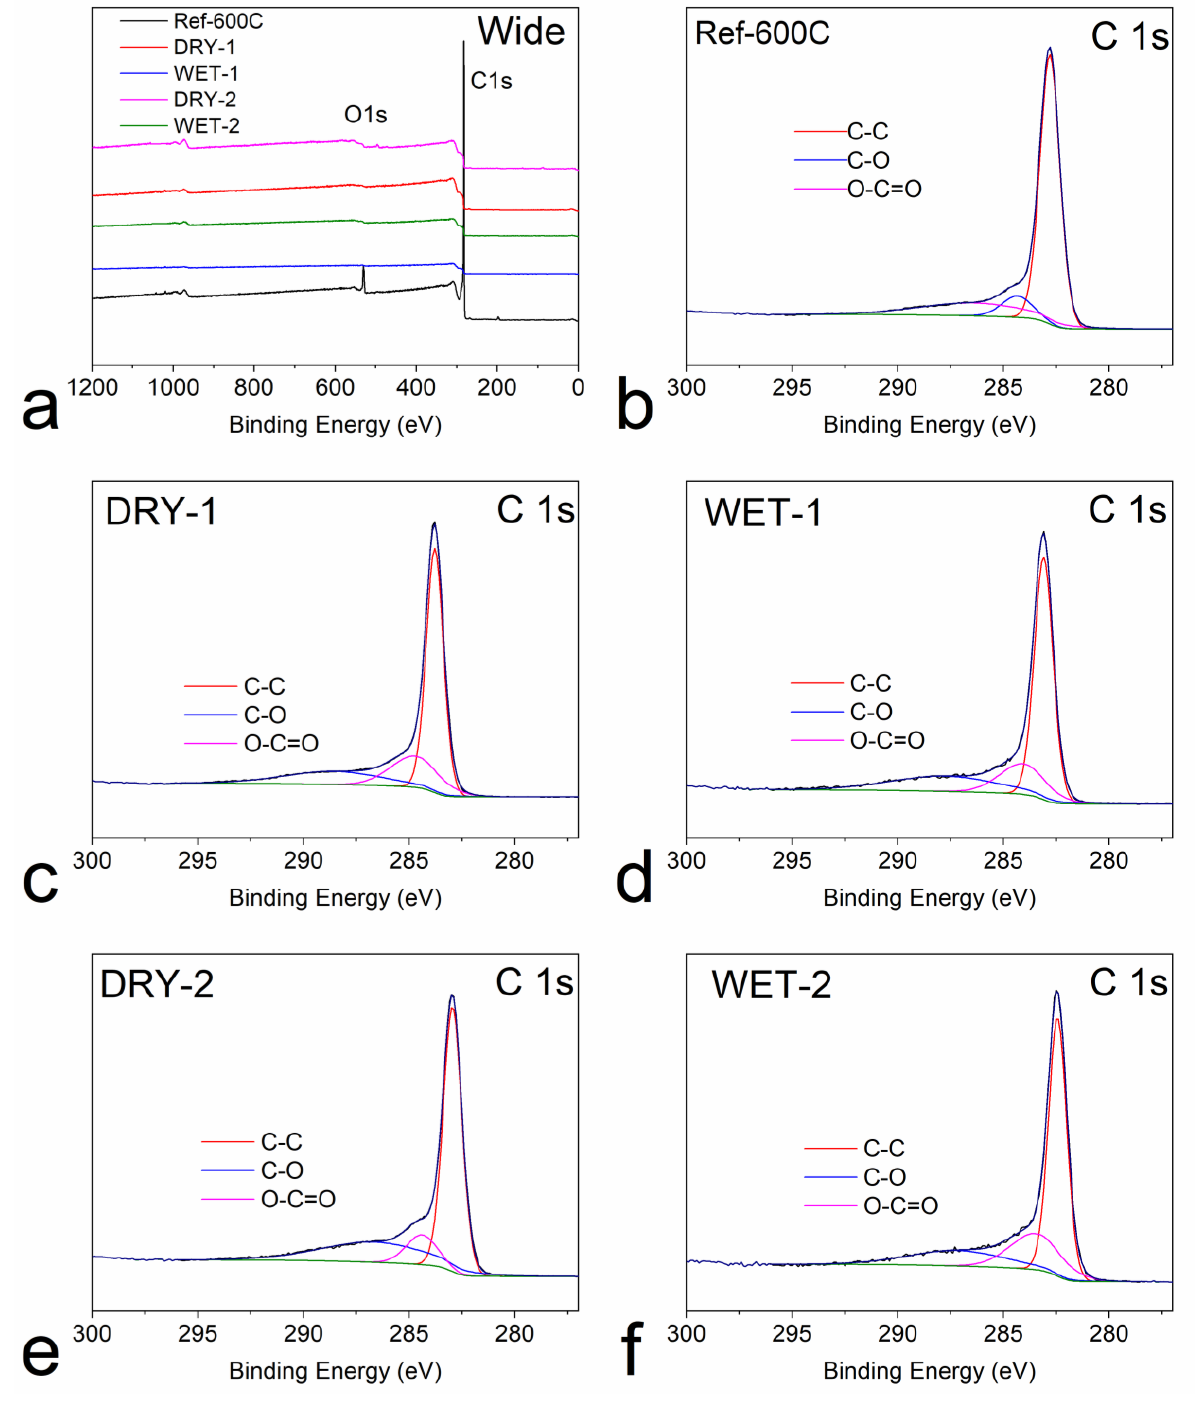
Figure 5. XPS spectra ( a ) wide spectra for all samples and C 1 s for ( b ) Ref-600C ( c ) DRY-1 ( d ) WET-1 ( e ) DRY-1 and ( f ) WET-2.